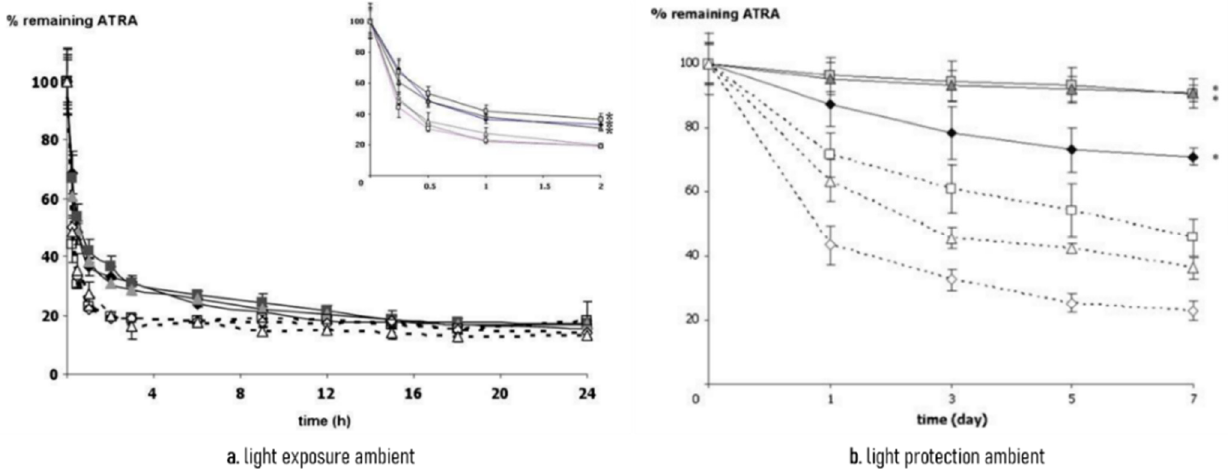
Figure 6. Remaining ATRA (%) in loaded PEG 750 -DPPE micelles (closed symbols) and 75% methanol/HBS solution (open symbols). Diamonds represent oxygen-filled environments, squares represent nitrogen-filled environments, and triangles represent ambient air (adapted from [20]). ( a ) light exposure ambient; ( b ) light protection ambient.